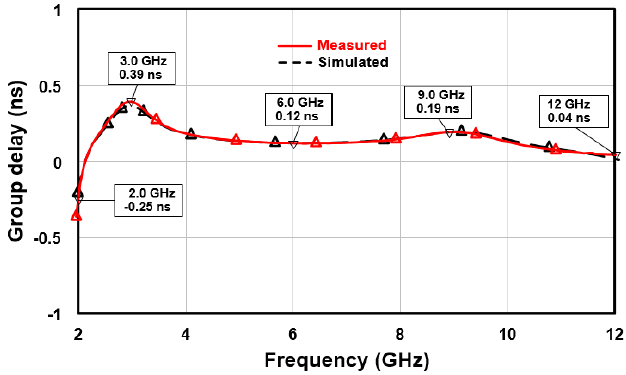
Figure 13. Measured and simulated group delay of the proposed filter.